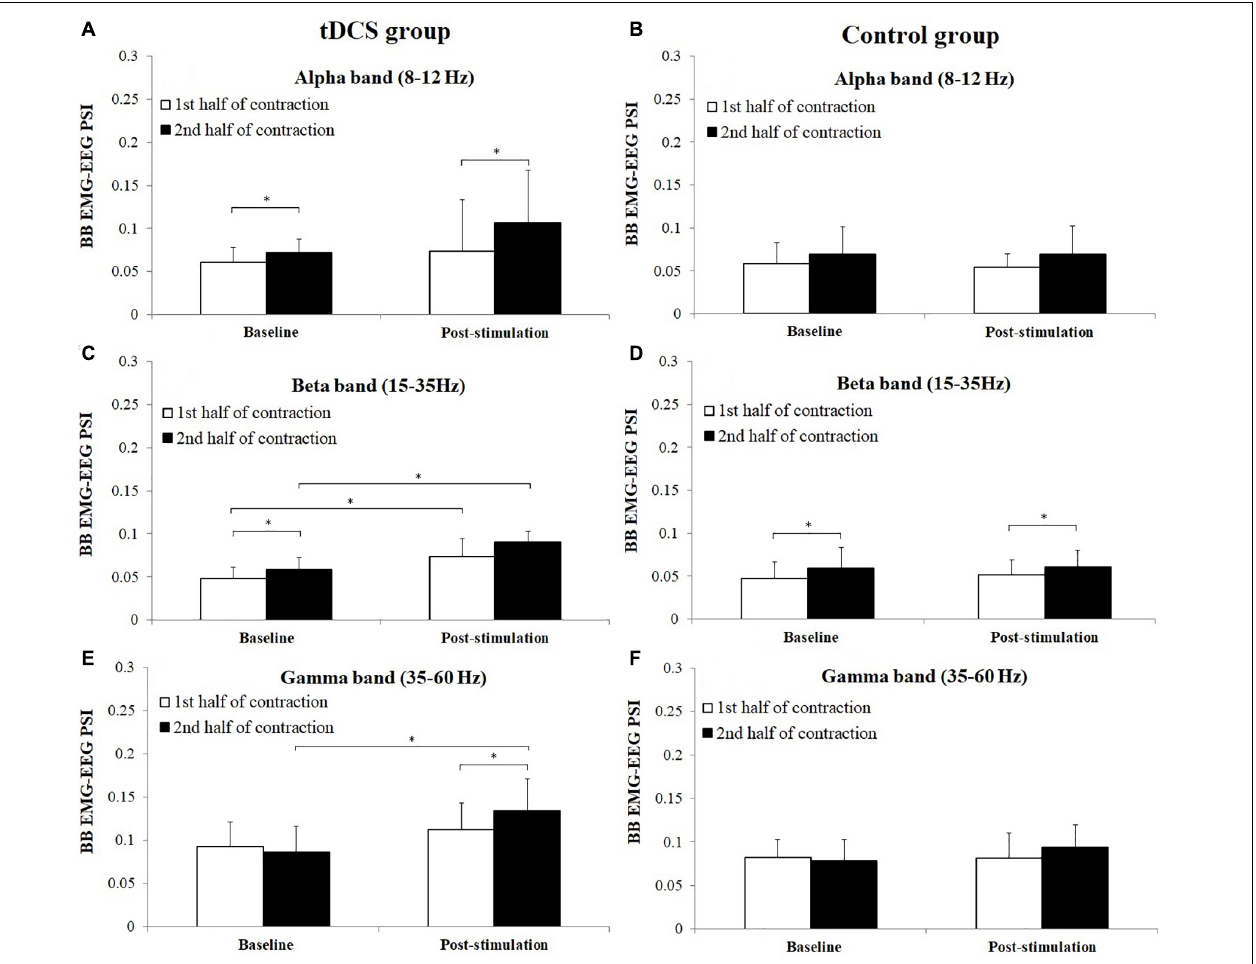
FIGURE 7 | Comparisons of biceps brachii (BB) electromyography (EMG)–electroencephalogram (EEG) phase synchronization index (PSI) (mean ± SD) in alpha, beta, and gamma frequency bands between the 1st and 2nd half of contraction for baseline and post-stimulation test in tDCS (A,C,E) and control (B,D,F) group subjects. *demonstrated a significant difference of observed index between the baseline and post-stimulation test or between the 1st and 2nd half of